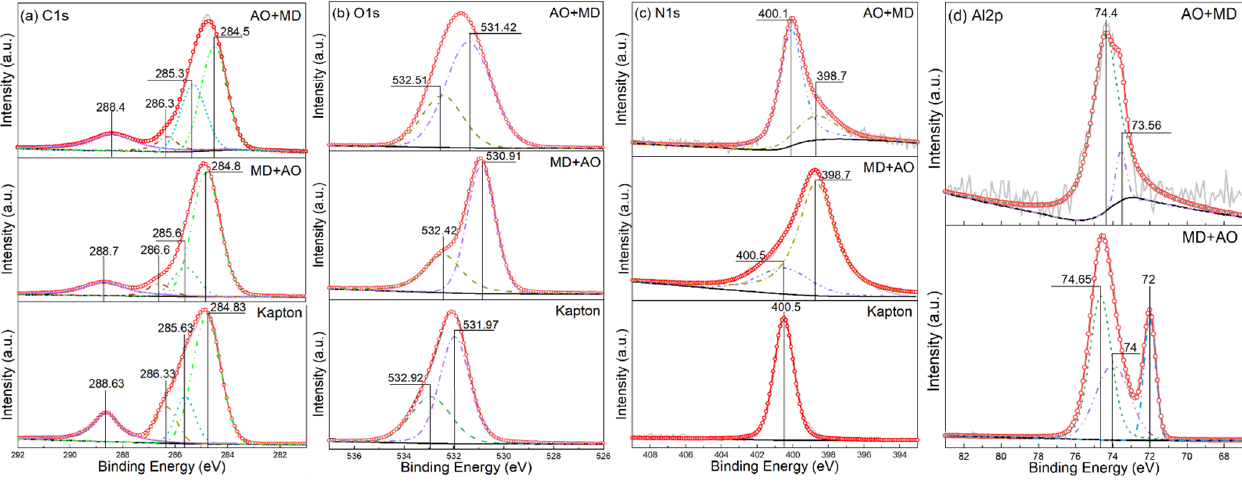
Figure 11. High-resolution XPS spectra of: ( a ) C1s, ( b ) O1s, ( c ) N1s, ( d ) Al2p on Kapton film before and after MD + AO, AO + MD load spectrum.